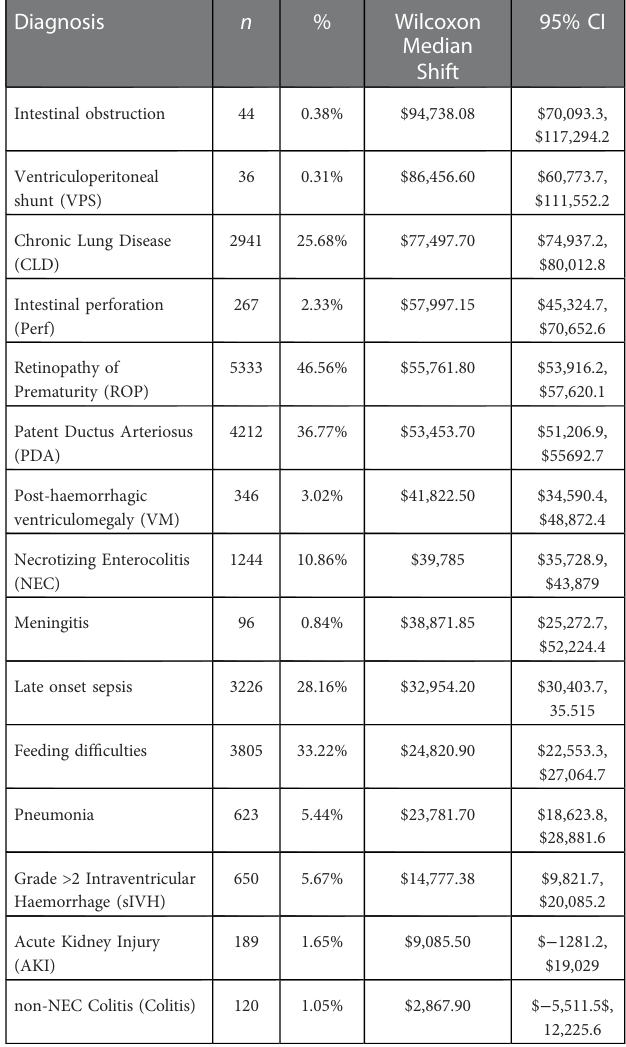
TABLE 2 Frequency and median costs of NICU care, by